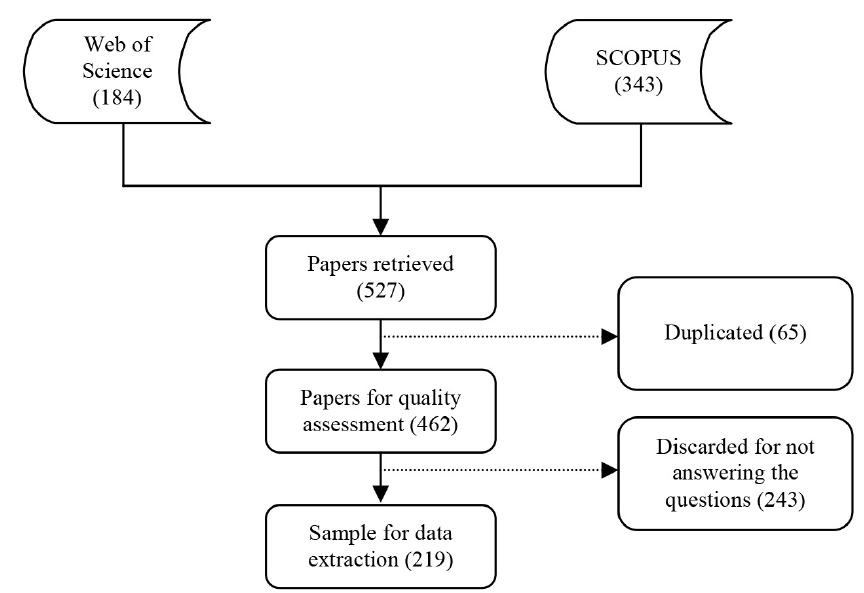
Figure 1. Study selection